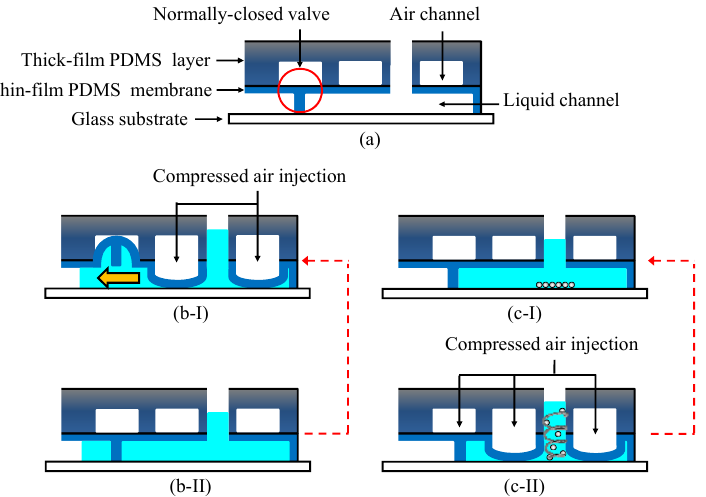
Figure 4. ( a ) Schematic illustration of the pneumatic micropump/micromixer; ( b -I) The working principle of the membrane-type micropump. The forward-motion of the fluids in the microchannel is activated as the compressed air is injected; ( b -II) The fluid in the microchannel is driven from the right side to the left side; ( c -I) Initial state of the micromixer without a supply of compressed air; ( c -II) The mixing state of the micromixer when supplied with compressed